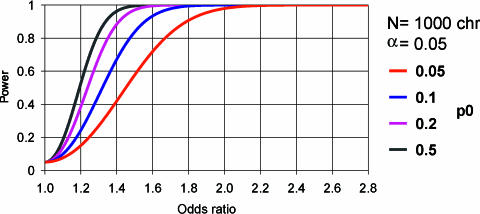
Power CalculationsPower of the current Cambridgeshire Case-Control Study to detect associations with risk allele of varying frequencies and with a Type 1 error rate of 5%. Abbreviations: p0, frequency of the predisposing allele; chr, number of chromosomes. Graphs were plotted with the PS power and sample-size program (available at http://www.mc.vanderbilt.edu/prevmed/ps; DuPont and Plummer 1997).